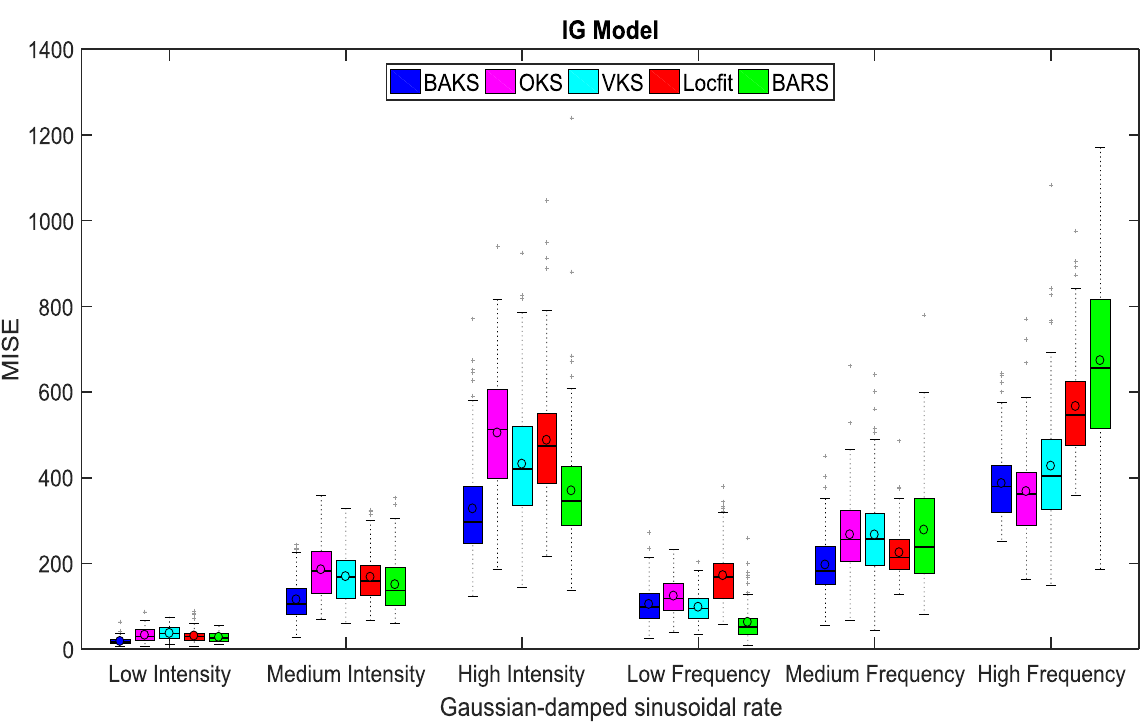
Fig 9. MISE comparison under different underlying rate functions for IG model. In each boxplot, black lines show the medians; black circles indicate the means; colored solid boxes represent interquartile ranges; whiskers extend 1.5 × from upper and lower quartiles; gray crosses represent